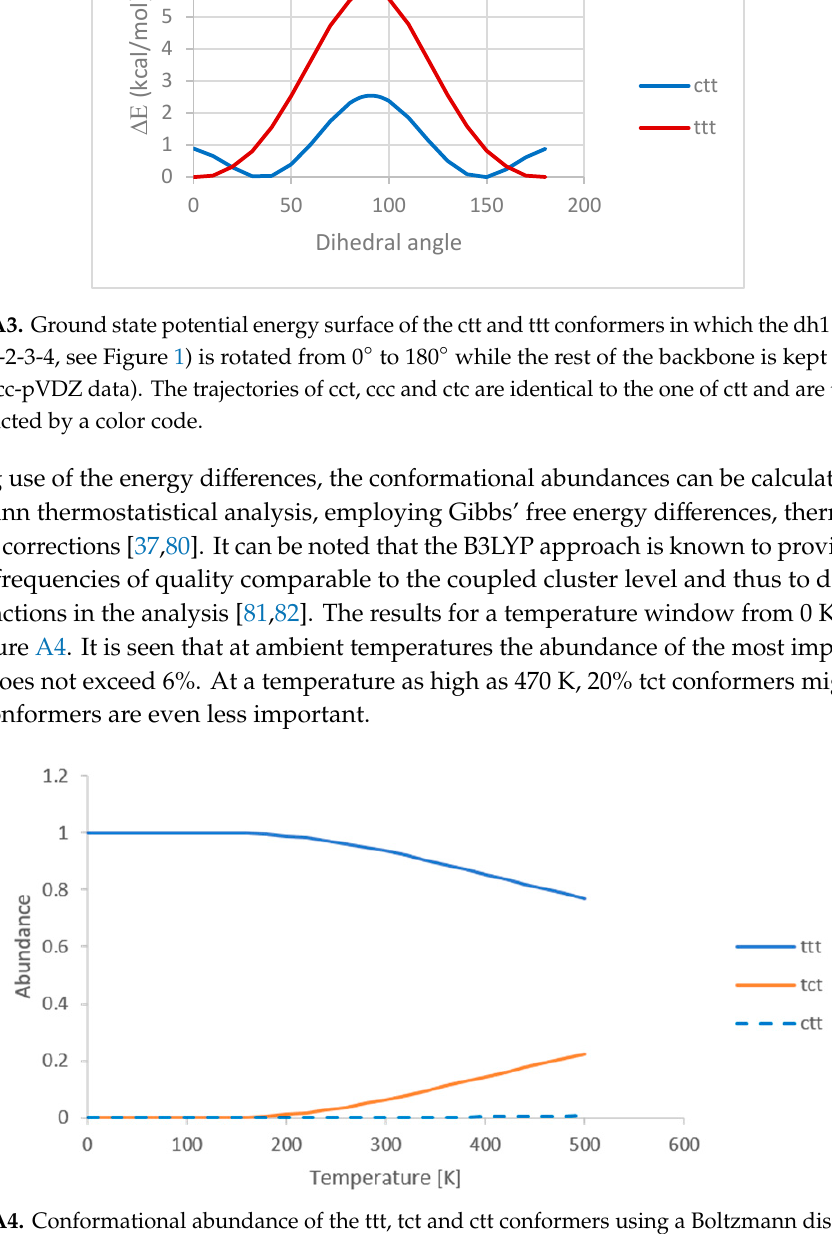
Figure A5. Values of the 7 dihedral angles of DPH observed in all 40 snapshots selected over the trajectories for DOPC (Ld) and DPPC (So). dh7 is defined with respect to the opposite side of the phenyl ring compared to dh1.